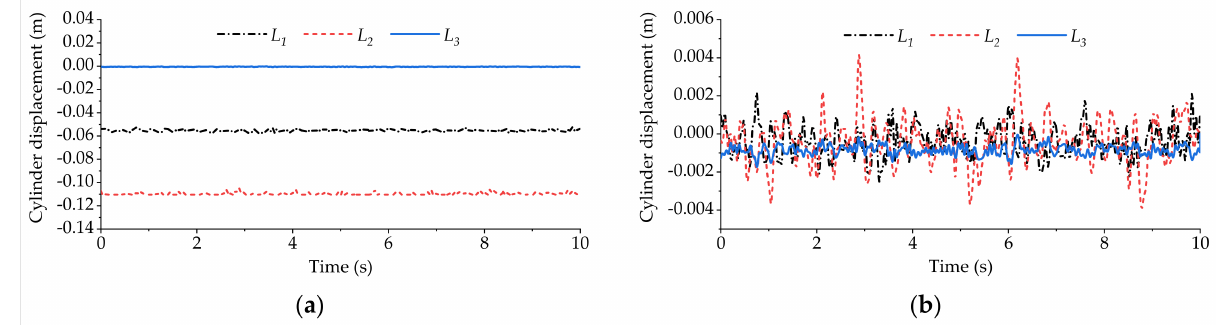
Figure 21. The displacement of equivalent suspension servo actuator cylinder in the cross slope experiment: ( a ) displacement of equivalent suspension servo actuator cylinder without high-pass filter; ( b ) displacement of equivalent suspension servo actuator cylinder when high-pass filter is